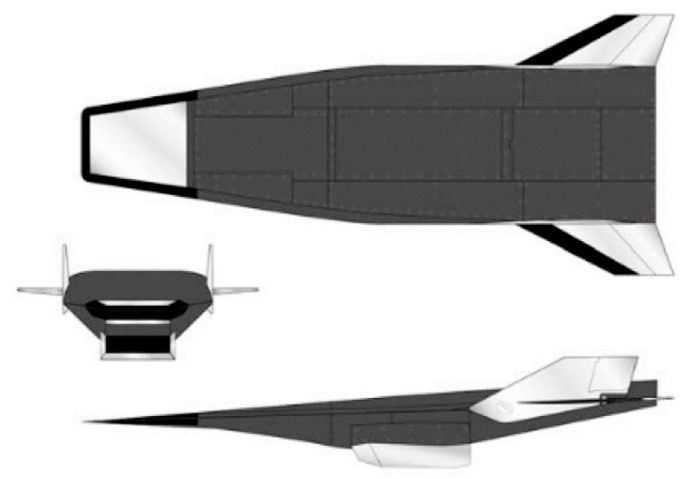
Figure 5. NASA’s X-43A vehicle.